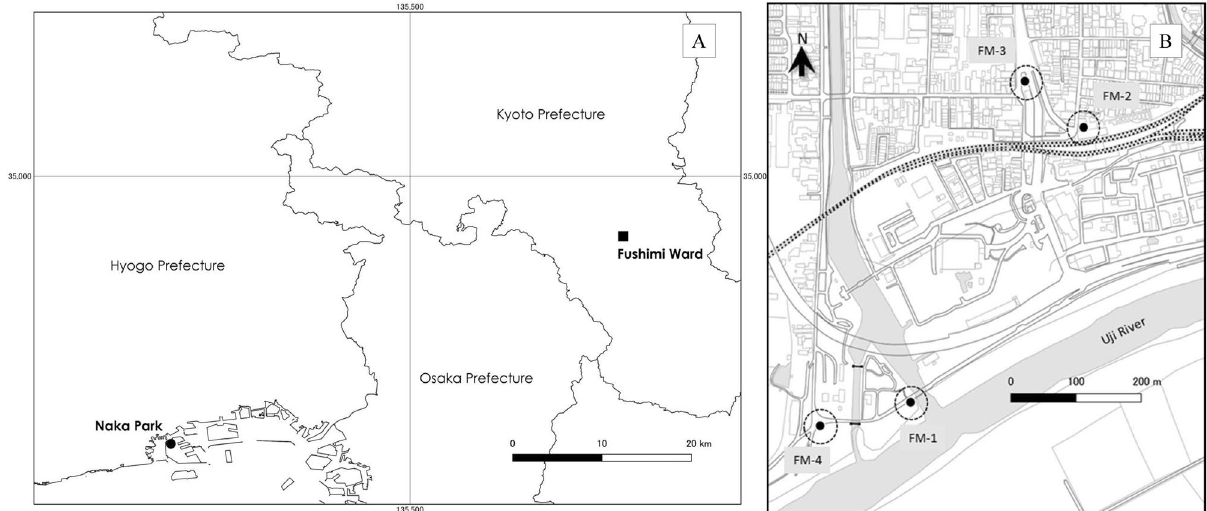
Figure 1. Locations of Naka Park and Fushimi Ward. ( A ) Each marker indicates the sampling sites (filled circle: Naka Park, Port Island, Kobe City and filled square: Fushimi Ward, Kyoto City). ( B ) Detailed map of the sampling area in Fushimi. The coordinates of the sampling sites are shown in Table S1. Figure S2 shows the sampling sites of Fushimi. This map was created using QGIS version 3.12.2 (http:// www. qgis. org/) based on the Administrative Zones Data (http:// nlftp. mlit. go. jp/ ksj/ gml/ datal ist/ KsjTm plt- N03- v2_3. html) which were obtained from free download service of the National Land Numerical Information (http:// nlftp. mlit. go. jp/